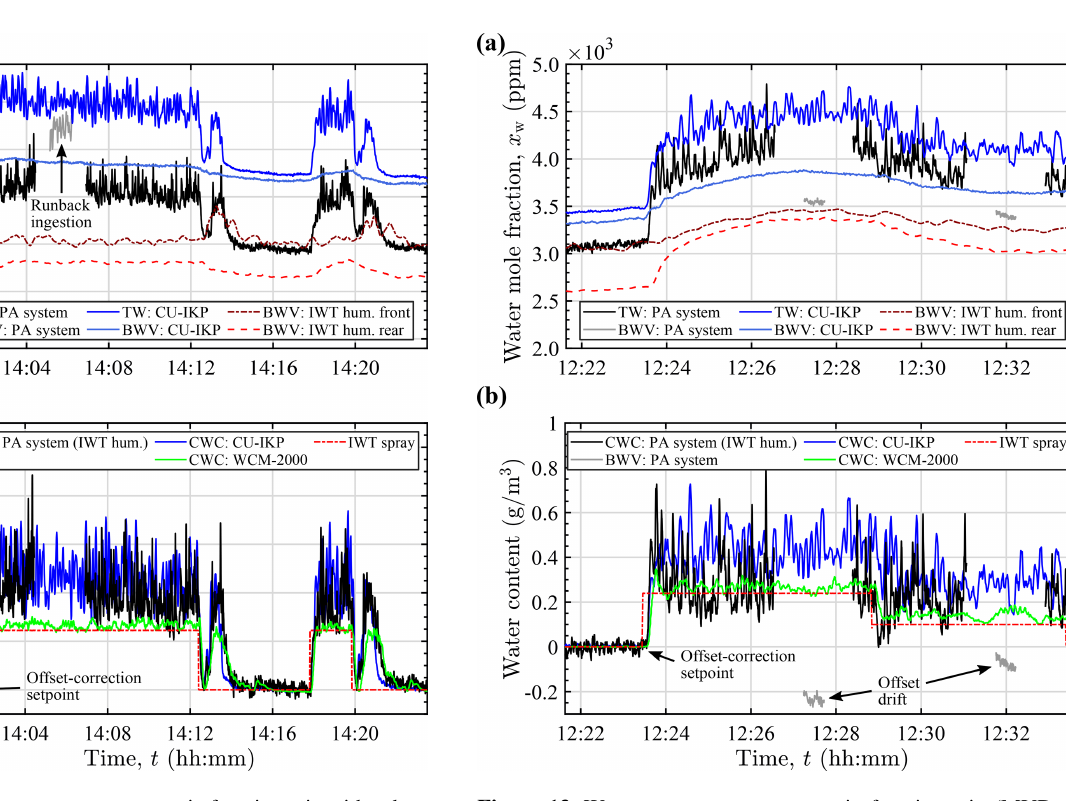
Figure 13. Water content measurement in freezing rain (MVD of 550µm, − 5 ◦ C, 60ms − 1 ) showing underestimated CWC due to significant background humidity offset drift. (a) PA instrument and CU-IKP TW and BWV mole fraction (extended PA instrument probe BWV inlet), together with BWV mole fractions calculated from the IWT humidity measurements. (b) CWC determined by the PA system (in combination with IWT humidity rear ), the CU-IKP, and the hot-wire probe (WCM-2000). BWV: PA system shows the residual background offset between the PA system’s BWV measure- ment and IWT humidity rear after offset correction. Spray activation is indicated by IWT spray